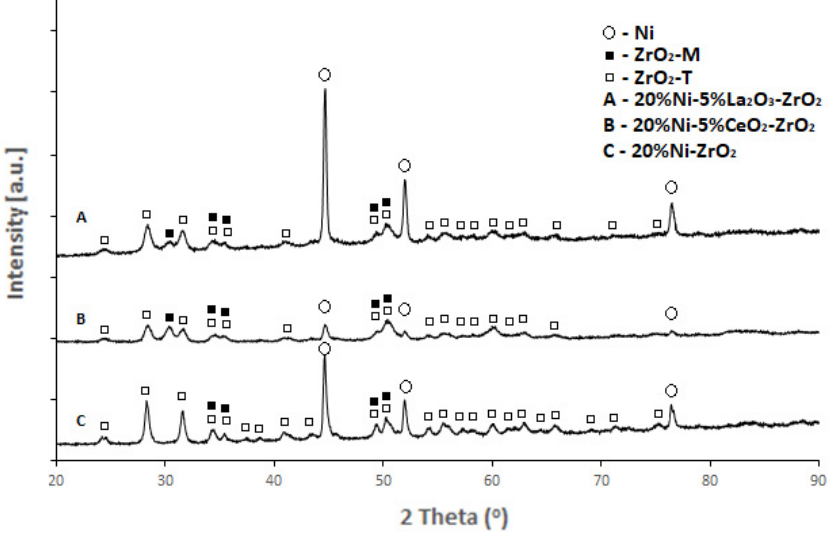
Figure 11. XRD curves of spent 20%Ni catalysts supported on ZrO 2 , 5%La 2 O 3 -ZrO 2 , and 5%CeO 2 -ZrO 2 carriers. Table 1. Size of NiO crystallites estimated by the Scherrer method for a NiO peak (200) for an angle of 2theta = 43.36° obtained from XRD measurements performed for Ni catalysts calcined in an air atmosphere at 400 °C for 4h.